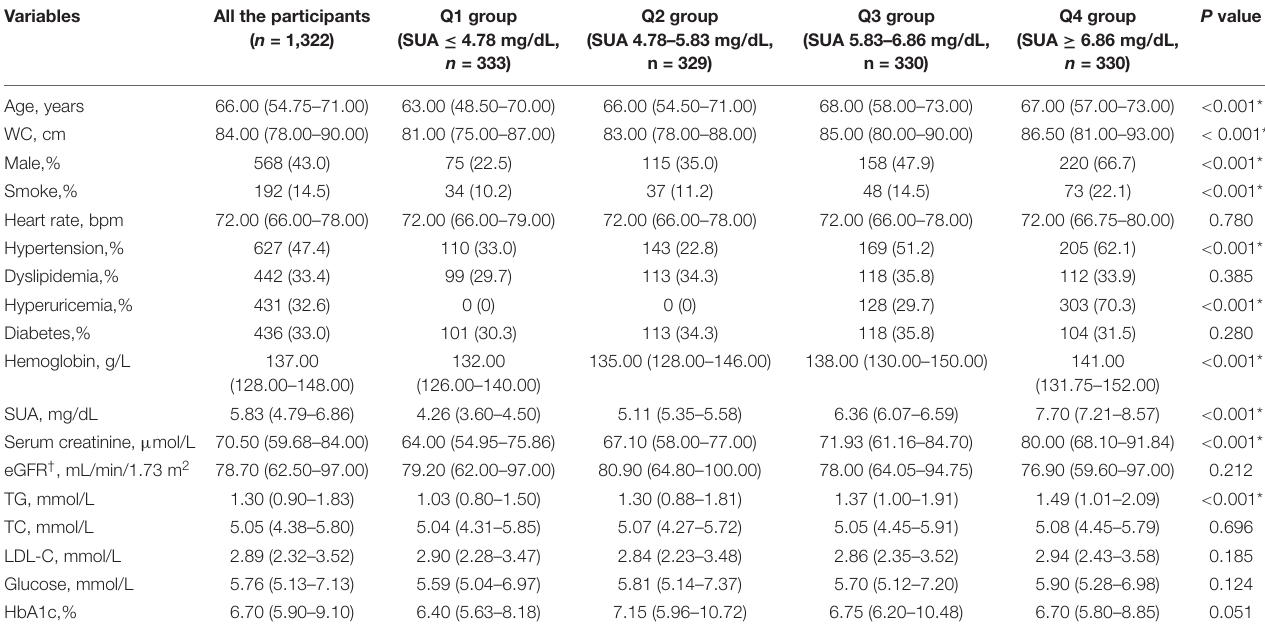
TABLE 1 | Clinical characteristics of participants according to quartiles of serum uric